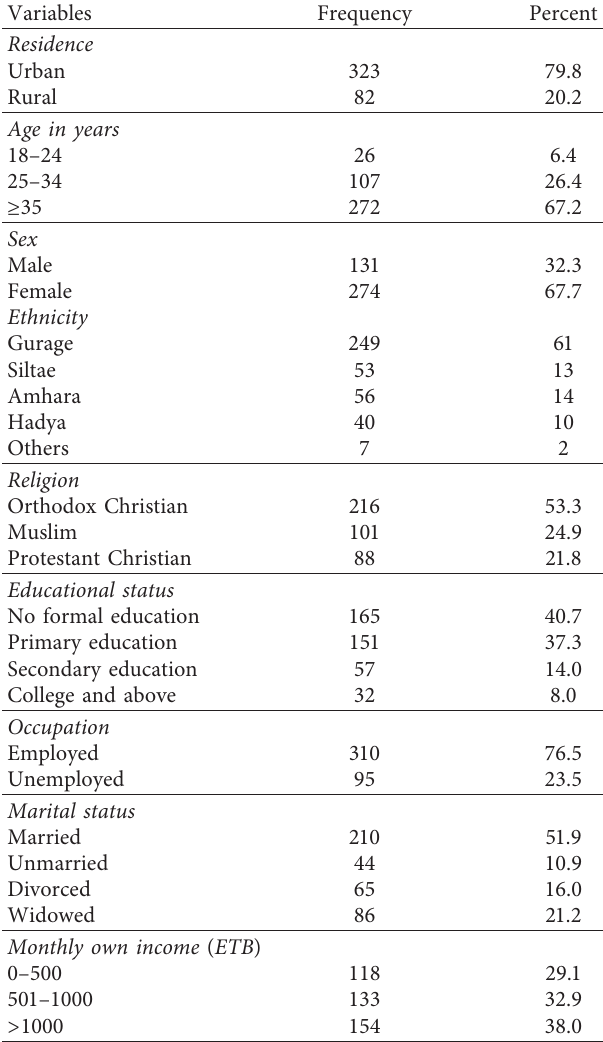
Table 1: Sociodemographic characteristics of ART patients at- tending public health facilities of Butajira town, Southern Ethiopia, 2019 ( n �